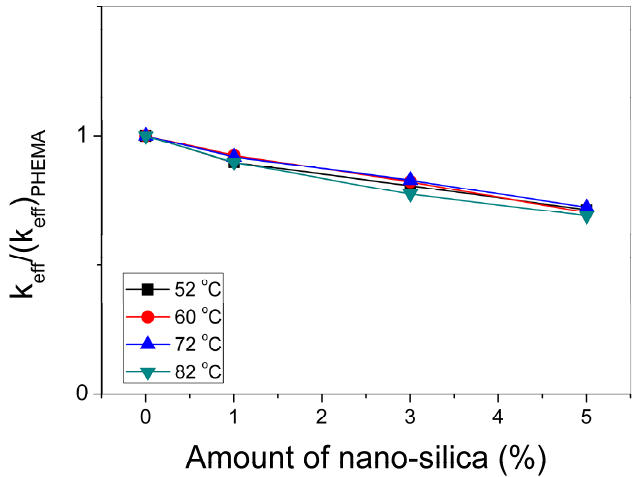
Figure 11. Relative effective kinetic rate constants obtained during polymerization of PHEMA/nano-silica nanocomposites at temperatures of 52, 60, 72 and 82 °C as a function of the amount of the additive.